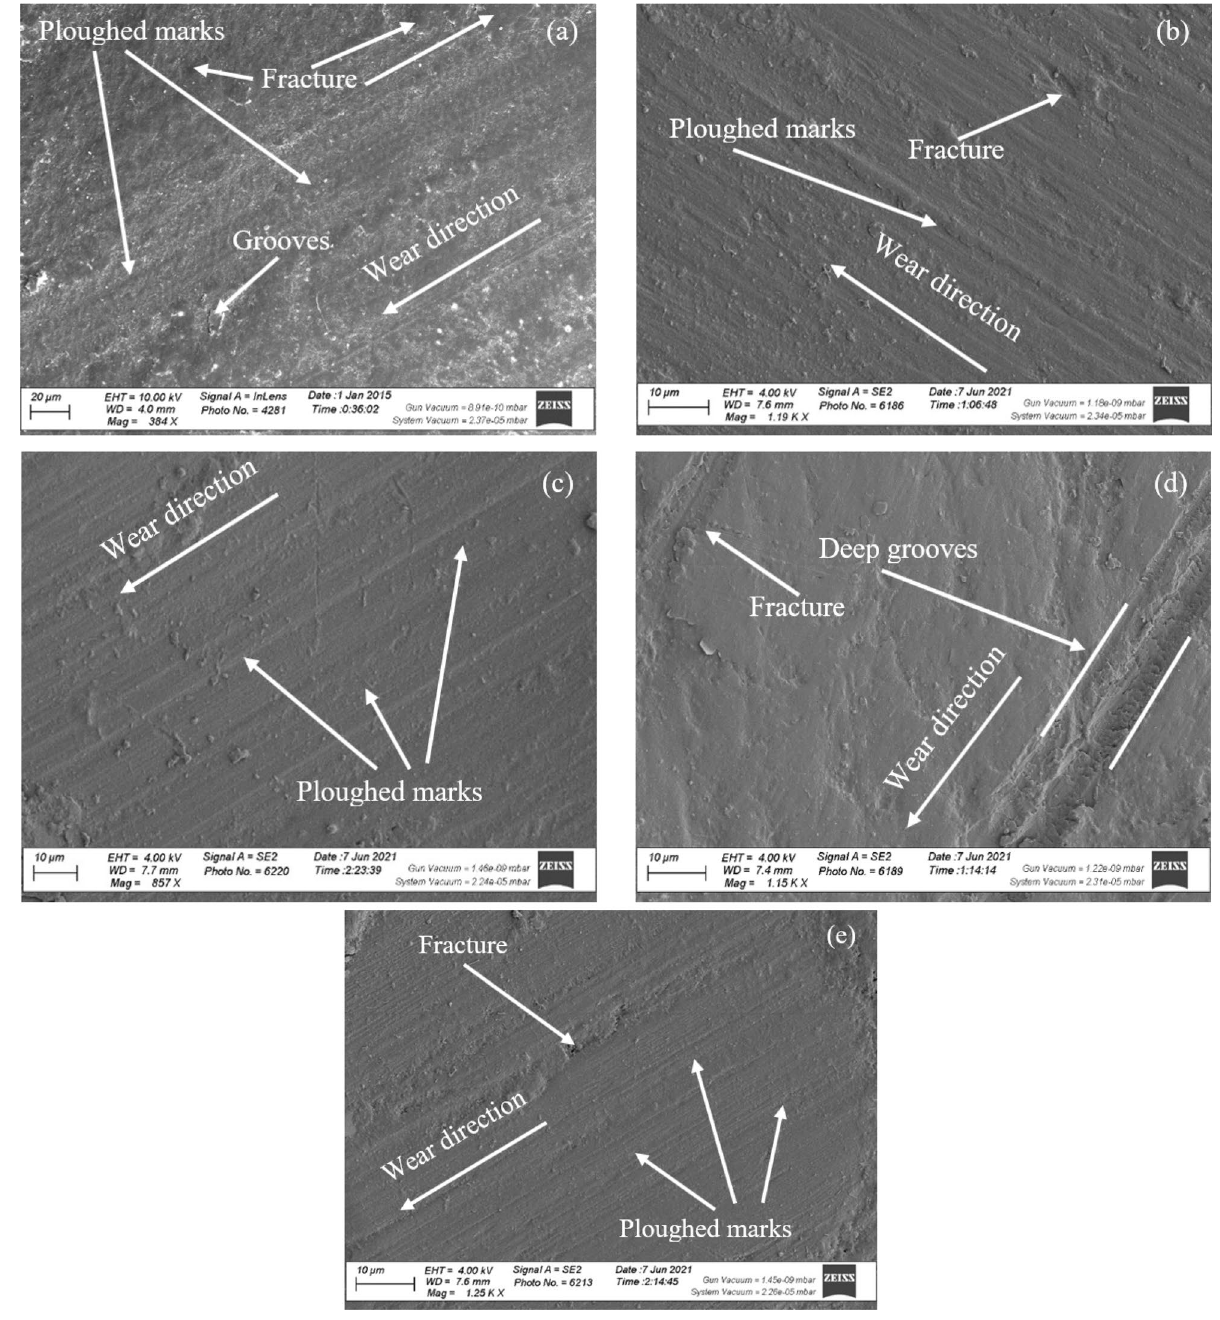
Figure 10. SEM micrographs of the worn surfaces for the raw and reinforced polymers. ( a ) pure PMMA, ( b ) PMMA-DSNP (1.2 wt%), ( c ) PMMA-TiO 2 NP (1.2 wt%), ( d ) PMMA-DSNP (1.5 wt%), and ( e ) PMMA-TiO 2 NP (1.5